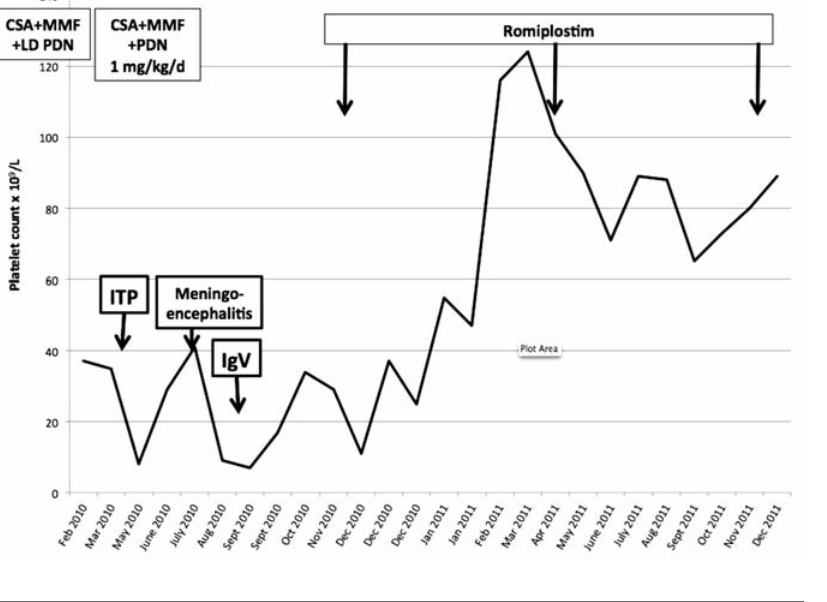
Figure 1. Platelet counts before immune thrombocytopenia (ITP) onset to 18-month fol- low-up. The patient was already on immunosuppressant treatment with Cislosporin A, Mycophenolate and low-dose prednisone, because of a previous liver transplant. Front- line steroid treatment for ITP reached only a transient response on platelet count but con- tributed to the development of a severe infectious complication (meningoencephalitis). After the first 3 weeks of romiplostim the platelet count rapidly increased above 50 ¥ 10 9 /L. Over the following months, the platelet count remained stable at around 70 ¥ 10 9